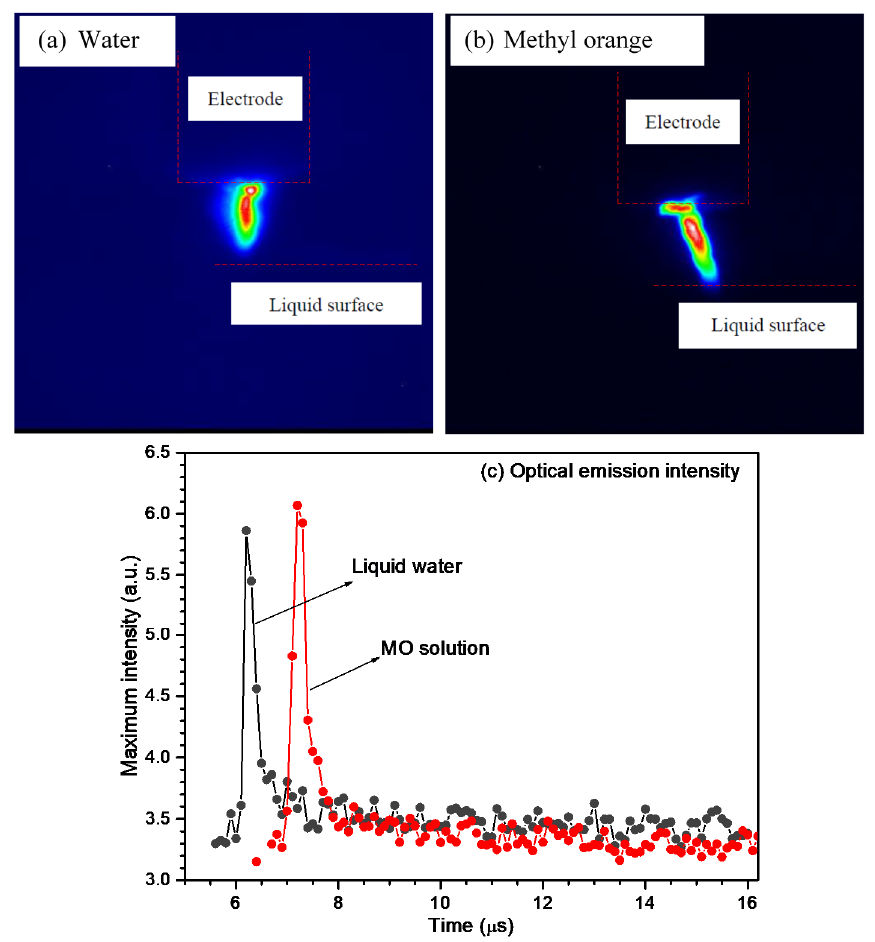
Figure 2. Typical arc plasma images ( a , b ) and their optical emission ( c ) intensities with copper as the electrode [38].